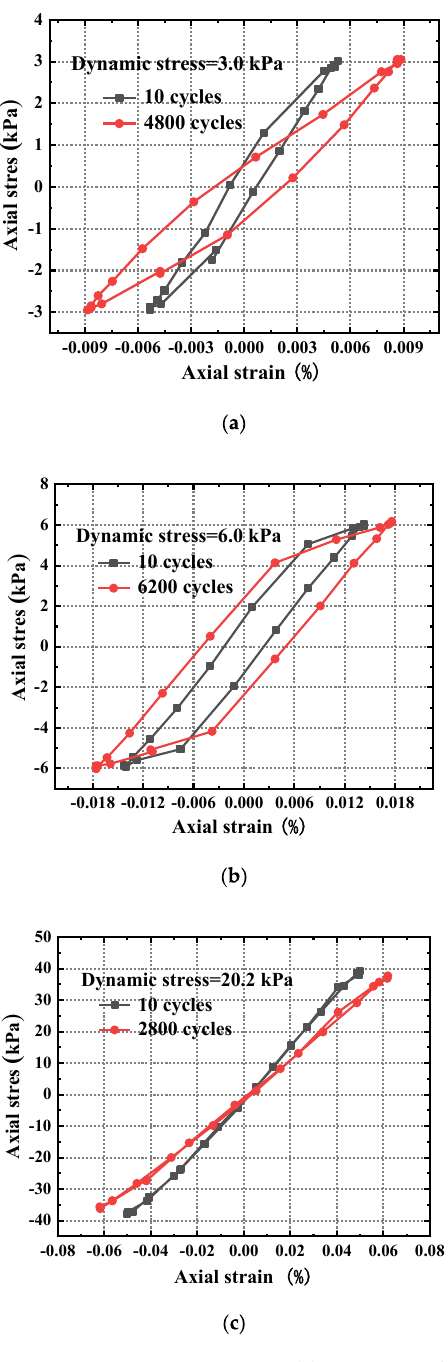
Figure 12. Hysteresis curve. ( a ) 2.5 m, 240 kPa (3.0 kPa); ( b ) 1.5 m, 240 kPa (6.0 kPa); ( c ) 0.5 m, 240 kPa (20.2